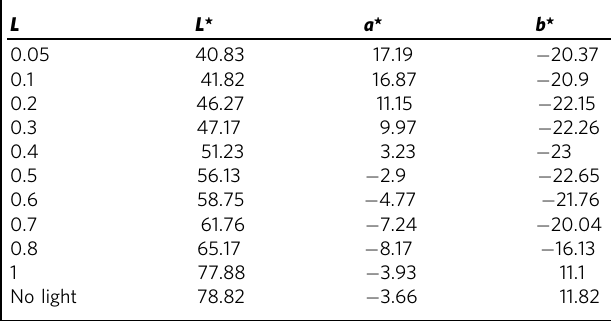
Table 3 L *, a *, and b * changes with different light density of MPV-based PSC-powered